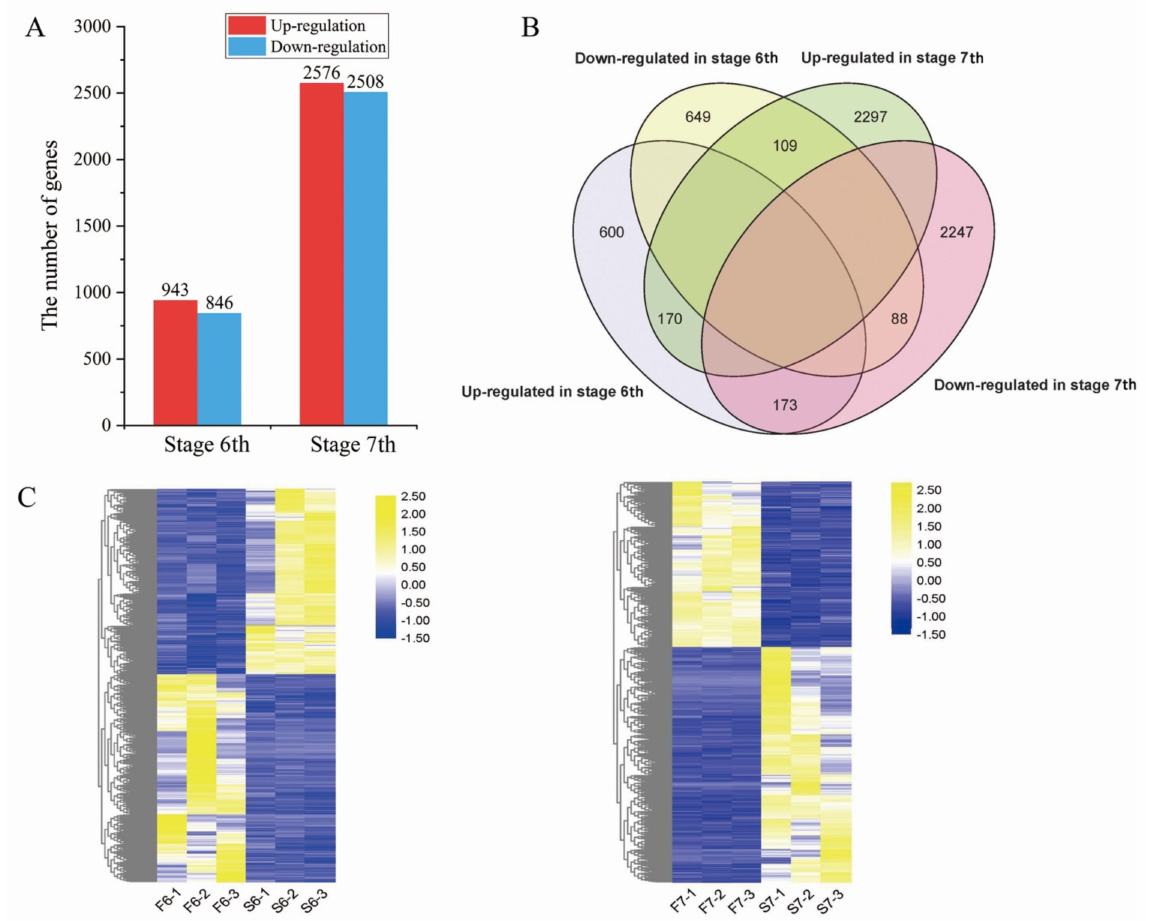
Figure 5. Differentially expressed genes (DEGs) in PA64S(S) and PA64S(F). ( A ) The number of genes upregulated or downregulated in response to temperature by > 1-fold in stages 6 and 7 ( p < 0.05). ( B ) Venn diagram showing the unique and shared DEGs in stages 6 and 7. ( C ) Hierarchical cluster analysis of DEGs in stages 6 and